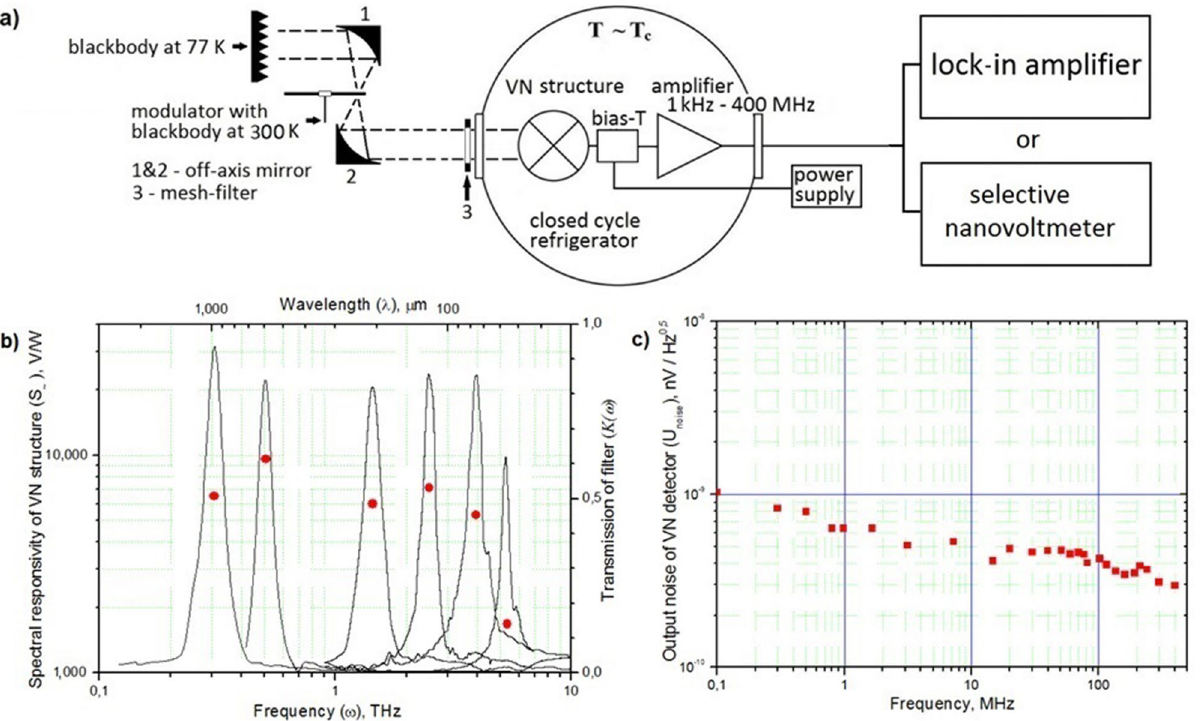
Figure 3. ( a ) The experimental setup for measuring the spectral sensitivity of VN structures using band-pass filters (mesh-filters) and blackbody loads in the frequency range ω ≈ (0.3–6) THz. The modulation frequency was chosen equal to ω mod ≈ 3 kHz. ( b ) The dependence of the spectral sensitivity of the VN structure (red circles) and the transmittance of band-pass filters (black lines) in the frequency range ω ≈ (0.3–6) THz. The spectral sensitivity of the VN structure is recorded using the lock-in amplifier. ( c ) The dependence of the spectral density of the noise voltage of the VN detector (red squares) on modulation frequency. The spectral density of the noise voltage of the VN detector is recorded using the selective nanovoltmeter without an input radiation for the VN